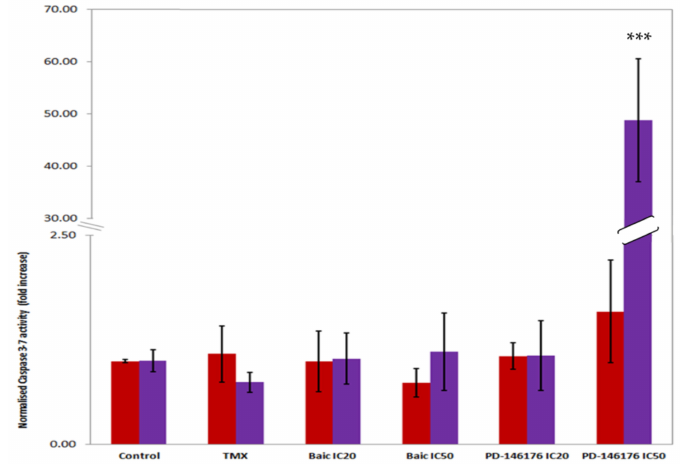
Figure 9. Caspase 3/7 activity in B16F10 incubated with 5-LOX inhibitors at IC 20 (red bars) and IC 50 (purple bars) concentrations, tamoxifen at 10 µ M (TMX) at 8 and 24 h. The Y axis shows the increase in Caspase 3–7 activity relative to the control. The luminescent signal was normalized to the number of cells (fold increase). The error bars show the standard deviation given from three independent assays. Error bars represent SD. Statistical significance by two-tailed unpaired t -test (*** p < 0.001).